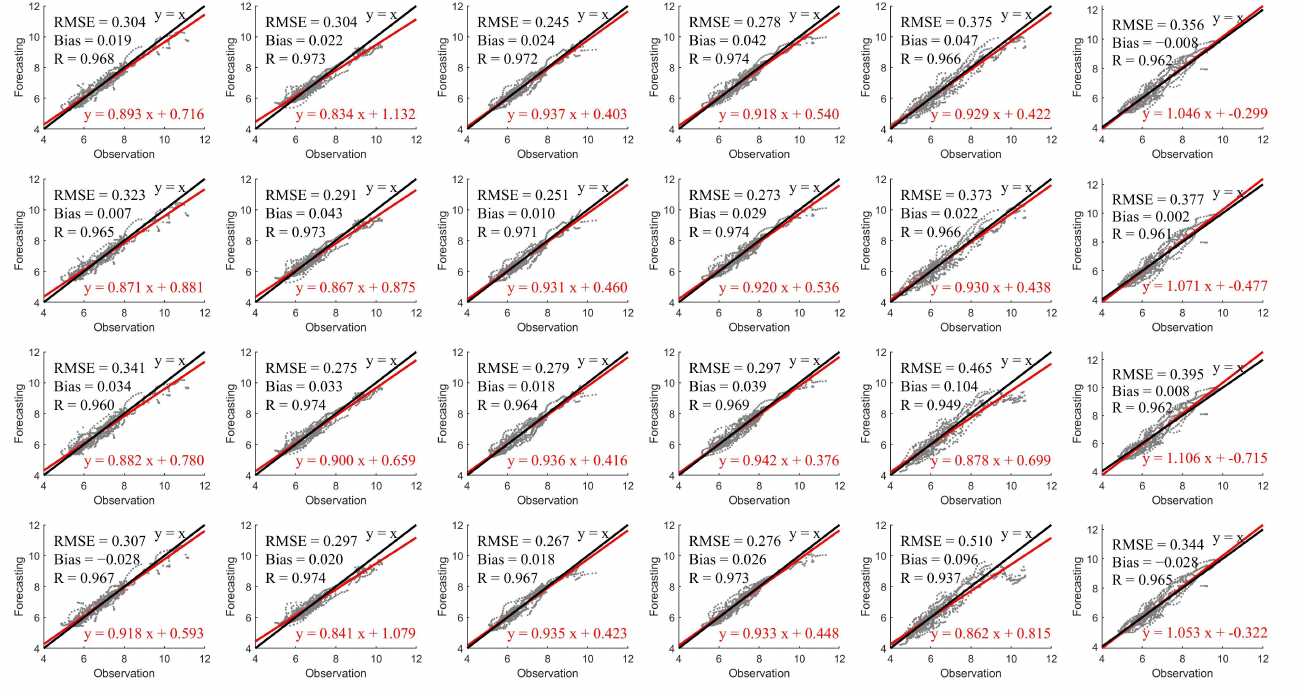
Figure 5. The same as Figure 4, but the subplots from top to bottom present the last four experiments in Table 3,